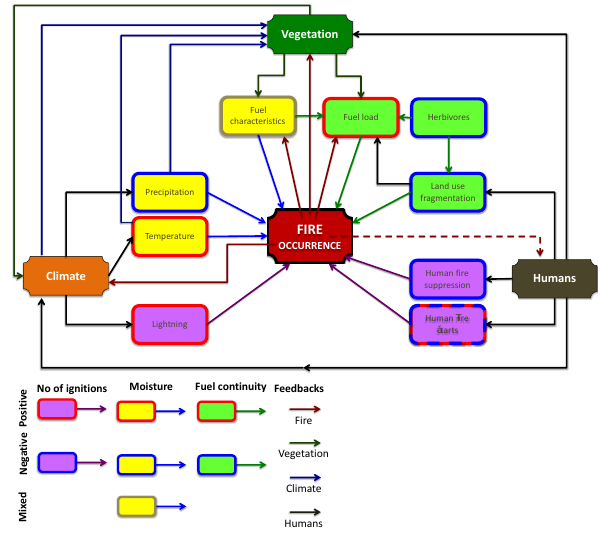
Figure 1. Summary of the interactions between the controls on fire occurrence on coarse scales. Green-, yellow-, and purple-filled boxes represent controls influencing fuel, moisture, and ignition, re- spectively. Red-outlined boxes indicates positive influence on fire, while blue indicates a negative influence and brown a mixed re- sponse. Brown arrows indicate interactions between people and other controls, and dark green arrows represent interactions between vegetation and other controls; dark blue arrows represent feedback from climate, black arrows show direct effects, and red arrows show feedback from fire. The arrow from fragmentation to fuel load indi- cates its effect on fuel